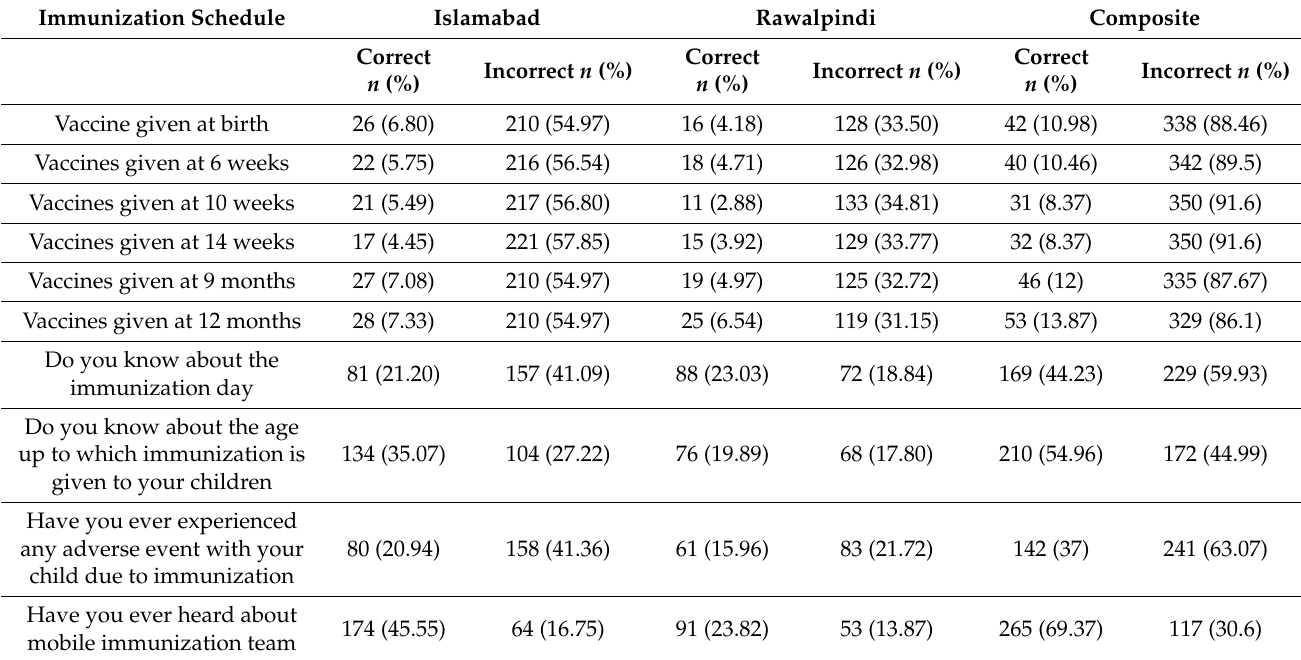
Table 5. Knowledge of parents regarding immunization and its schedule for their children under two years of age. Immunization Schedule